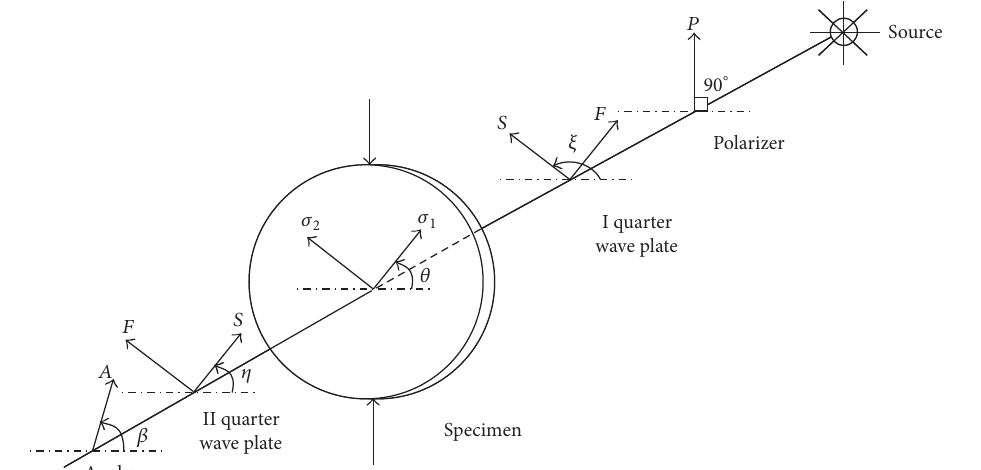
Figure 5: Arrangement of the circular polariscope.